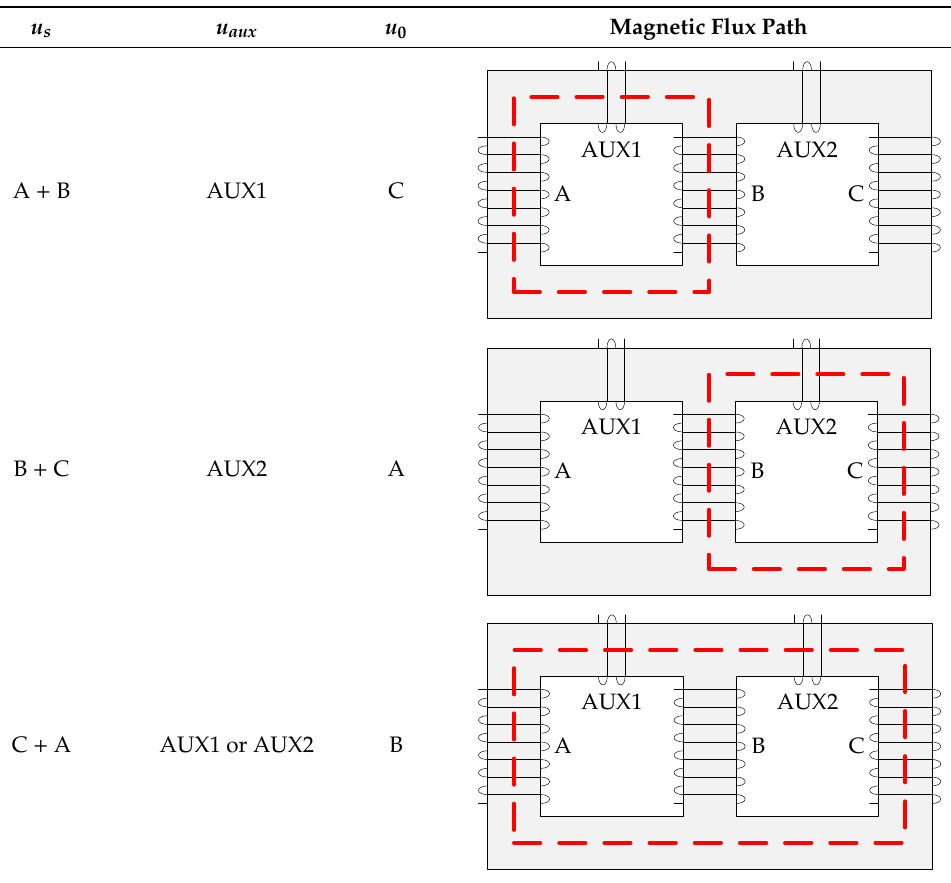
Table 2. Winding configurations of the equivalent B ( H ) measurement circuits.